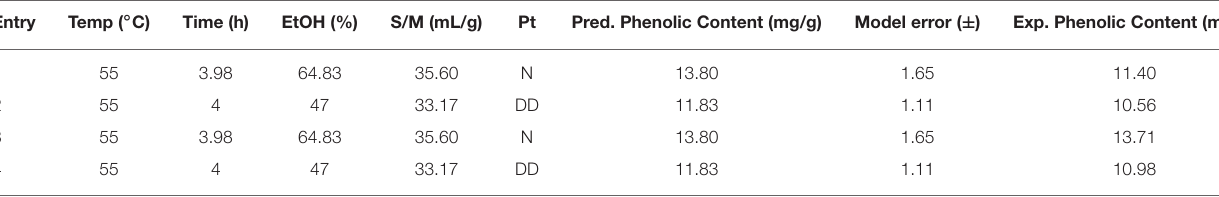
TABLE 4 | Validation of the model using optimal conditions for phenolics